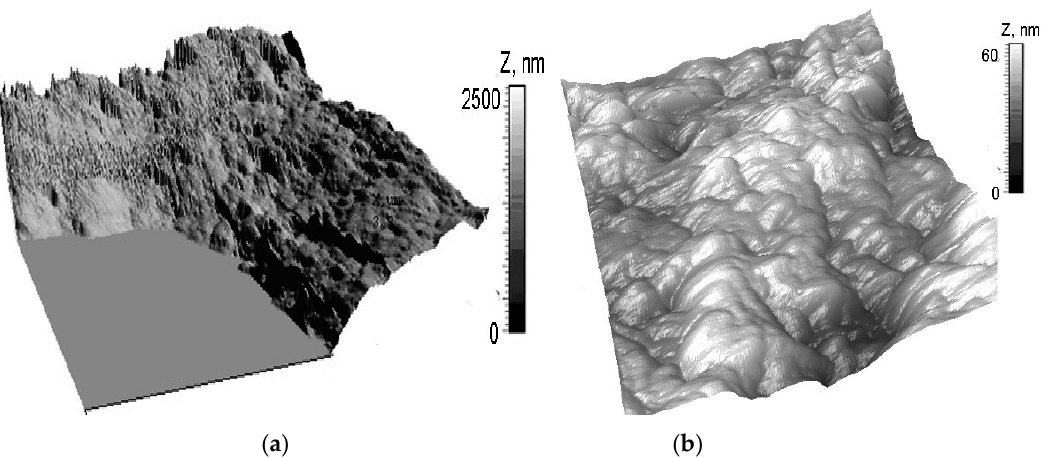
Figure 3. AFM images of a healthy human surface: ( a ) 9 × 9 µm 2 , Z max = 2500 nm, and ( b ) 3 × 3 µm 2 , Zmax = 60 nm.